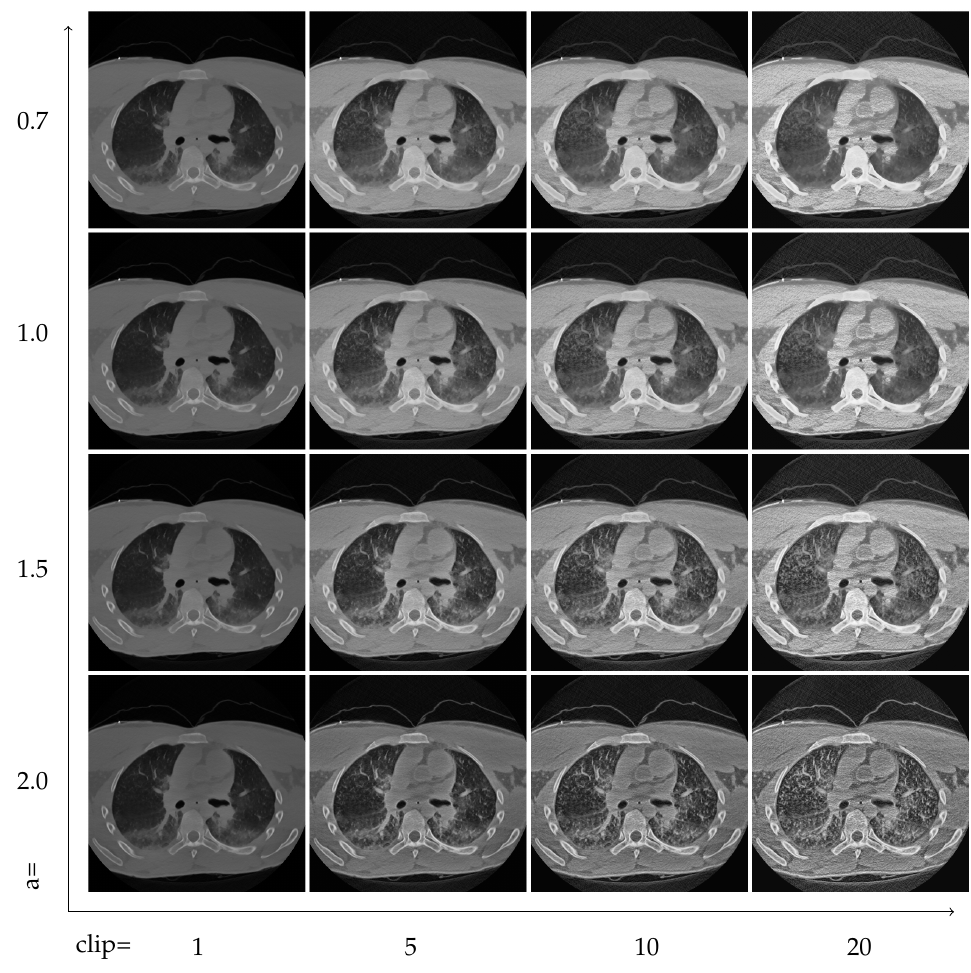
Figure 8. The effect of the 1/ r a weighting function and clipping. Rows from top to bottom have a = 0.7, 1.0, 1.5, 2.0, respectively, and the clip limits in the columns from left to right are 1, 5, 10 and 20, using 1/ N units where N is the number of histogram